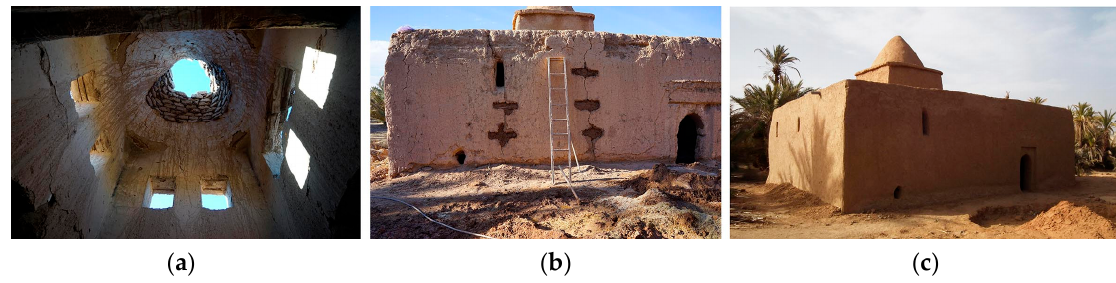
Figure 11. ( a ) Reconstruction works of the vault using adobe; ( b ) Sewing the wall with wooden keys; ( c ) Current status after restoration.